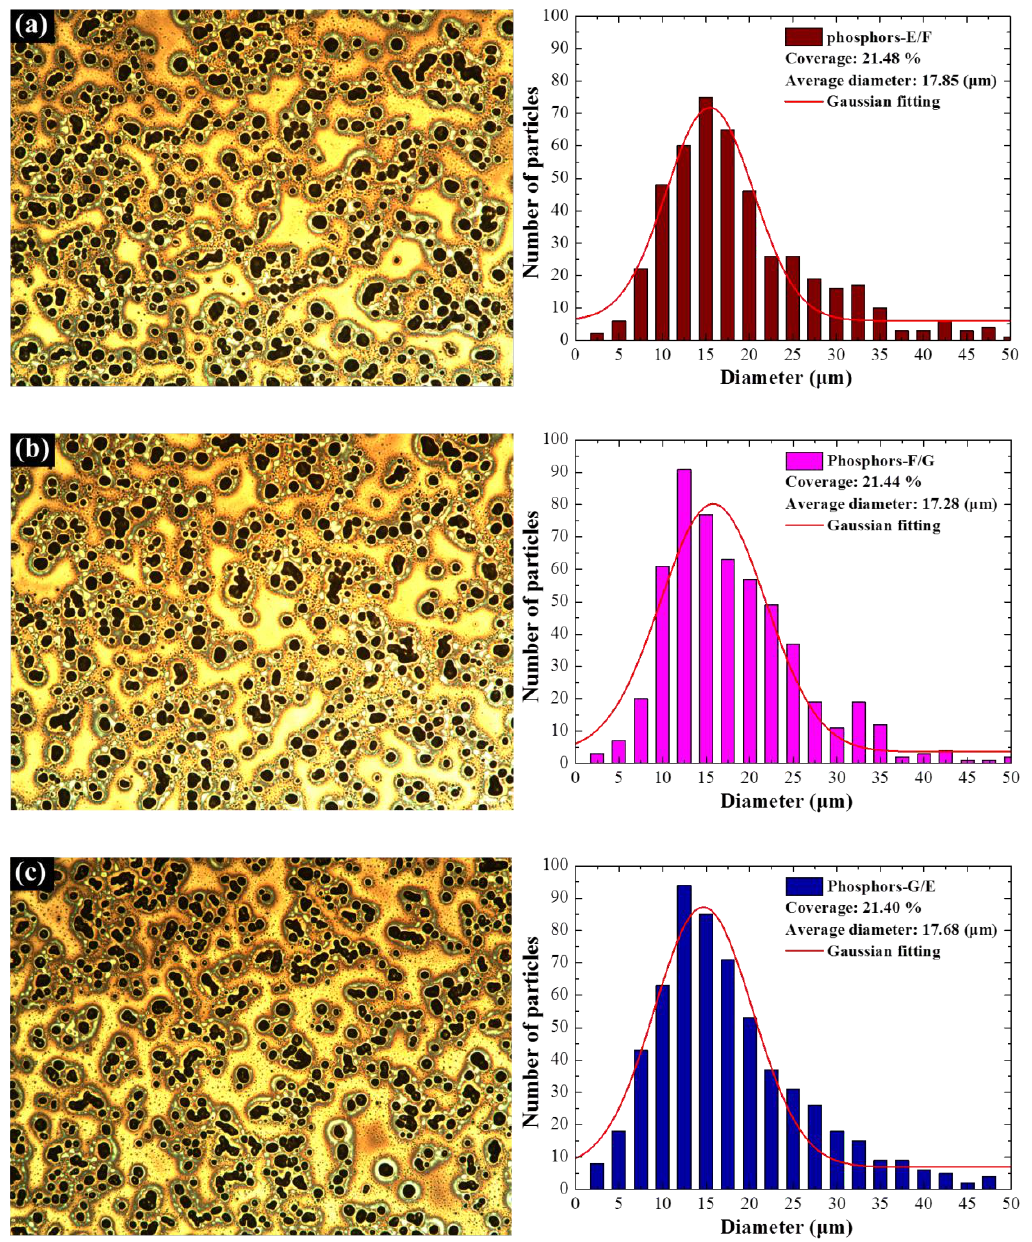
Figure 3. Optical images and particle-size distribution of samples with dual-coatings of phosphors: ( a ) E/F; ( b ) F/G; and ( c ) G/E.